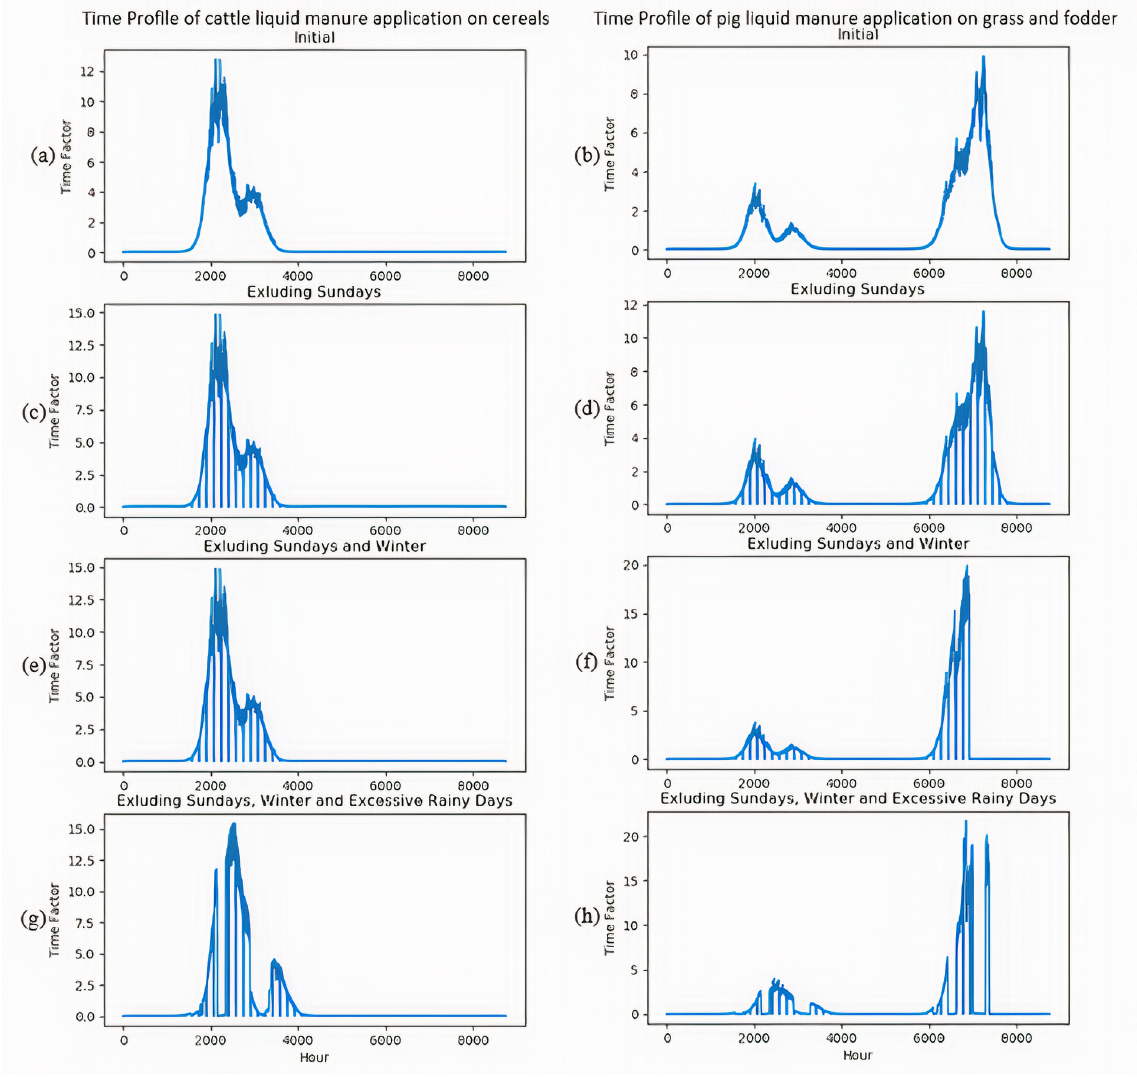
Figure H1. Two examples of the NH 3 emission time profile during the four phases of development at location (47.41, 10.98) in latitude– longitude: cattle slurry application on cereals (a, c, g, e) and pig liquid manure application on grass and fodder (b, d, f, h)